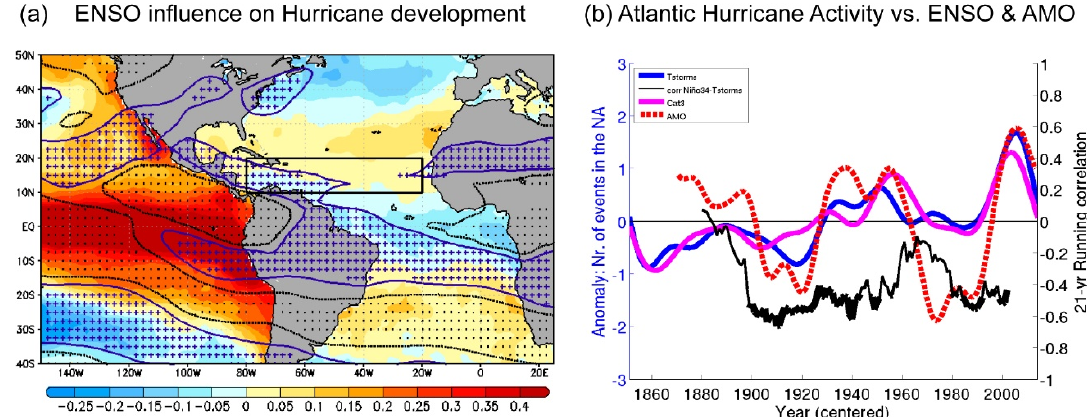
Figure 2 . ( a ) Previous August-October SSTs (red/blue shadings in K·std − 1 ) and vertical 850–250 hPa wind shear (black/purple contour values at ±0.5 m·s − 1 ·std − 1 ) regressed onto Niño 3.4 index (December-February). Statistically significant areas of enhanced/reduced wind shear marked with crosses/dots (95% confidence interval). The Atlantic Hurricane Main Development Region is shown in a black rectangle; ( b ) Anomaly from long term mean: Number of Tropical Storms and Hurricanes over the North Atlantic (June to November, blue and magenta lines—11 years smoothing). The Atlantic Multidecadal Oscillation index (red dashed line). Twenty-one-year running correlations (centered) between Tropical Storm activity (hurricanes included) and Niño 3.4 index (black line). There is a 95% confidence interval ( t test) in thicker segments. Data sources: HURDAT2 , HadISST and NCE P.